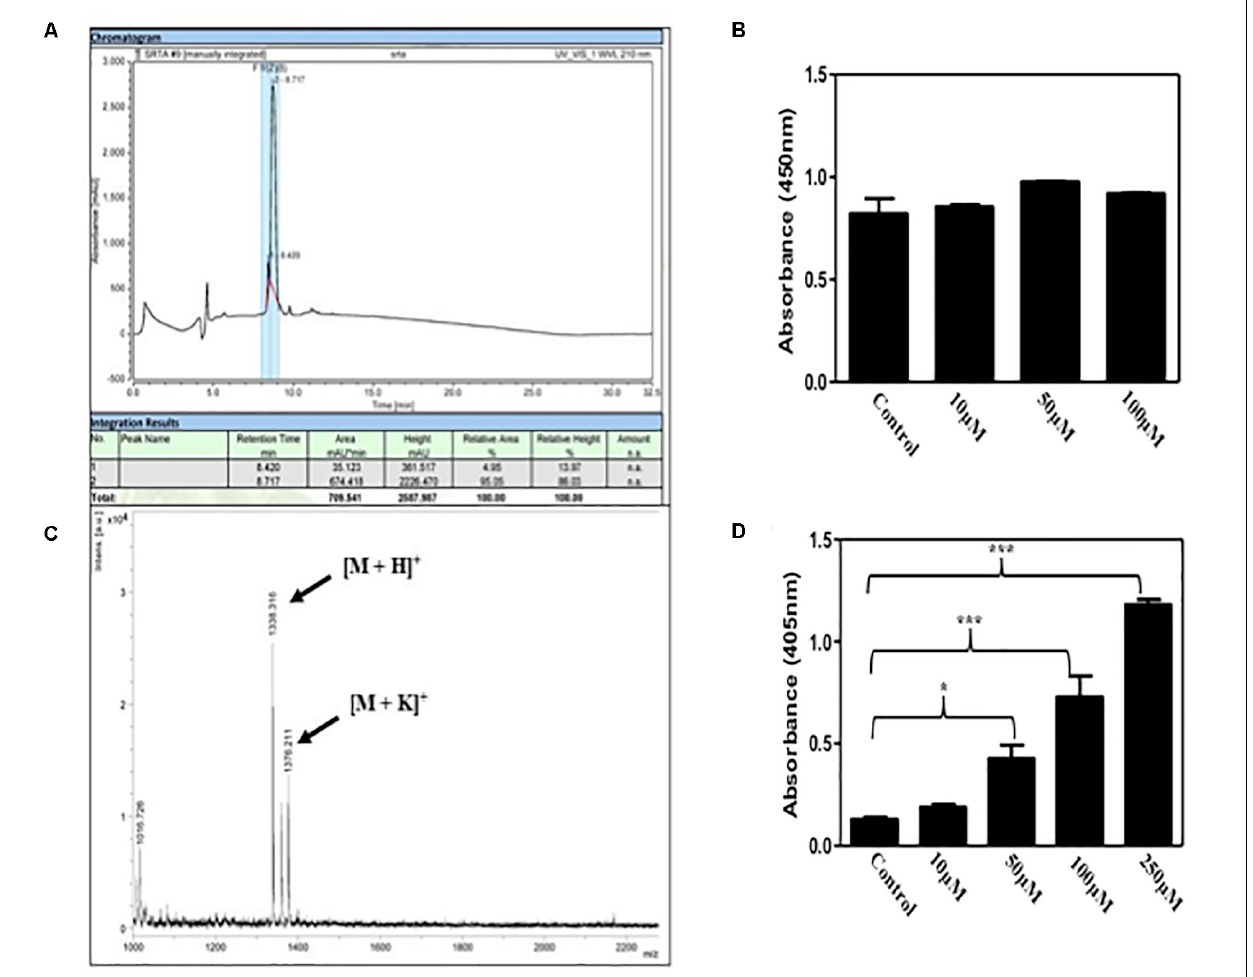
FIGURE 1 | (A) Reversed phase HPLC chromatogram of the 6His-LPETG peptide with retention time 8.717 min. (B) MALDI-TOF analysis peaks of 6His-LPETG peptide. 6His-LPETG peptide conjugation on cell surface of (C) S. aureus and (D) E. faecalis as measured by ELISA done in triplicates. P < 0.05 was considered as significant. Error bars are mean ± SEM. * p < 0.05, *** p <